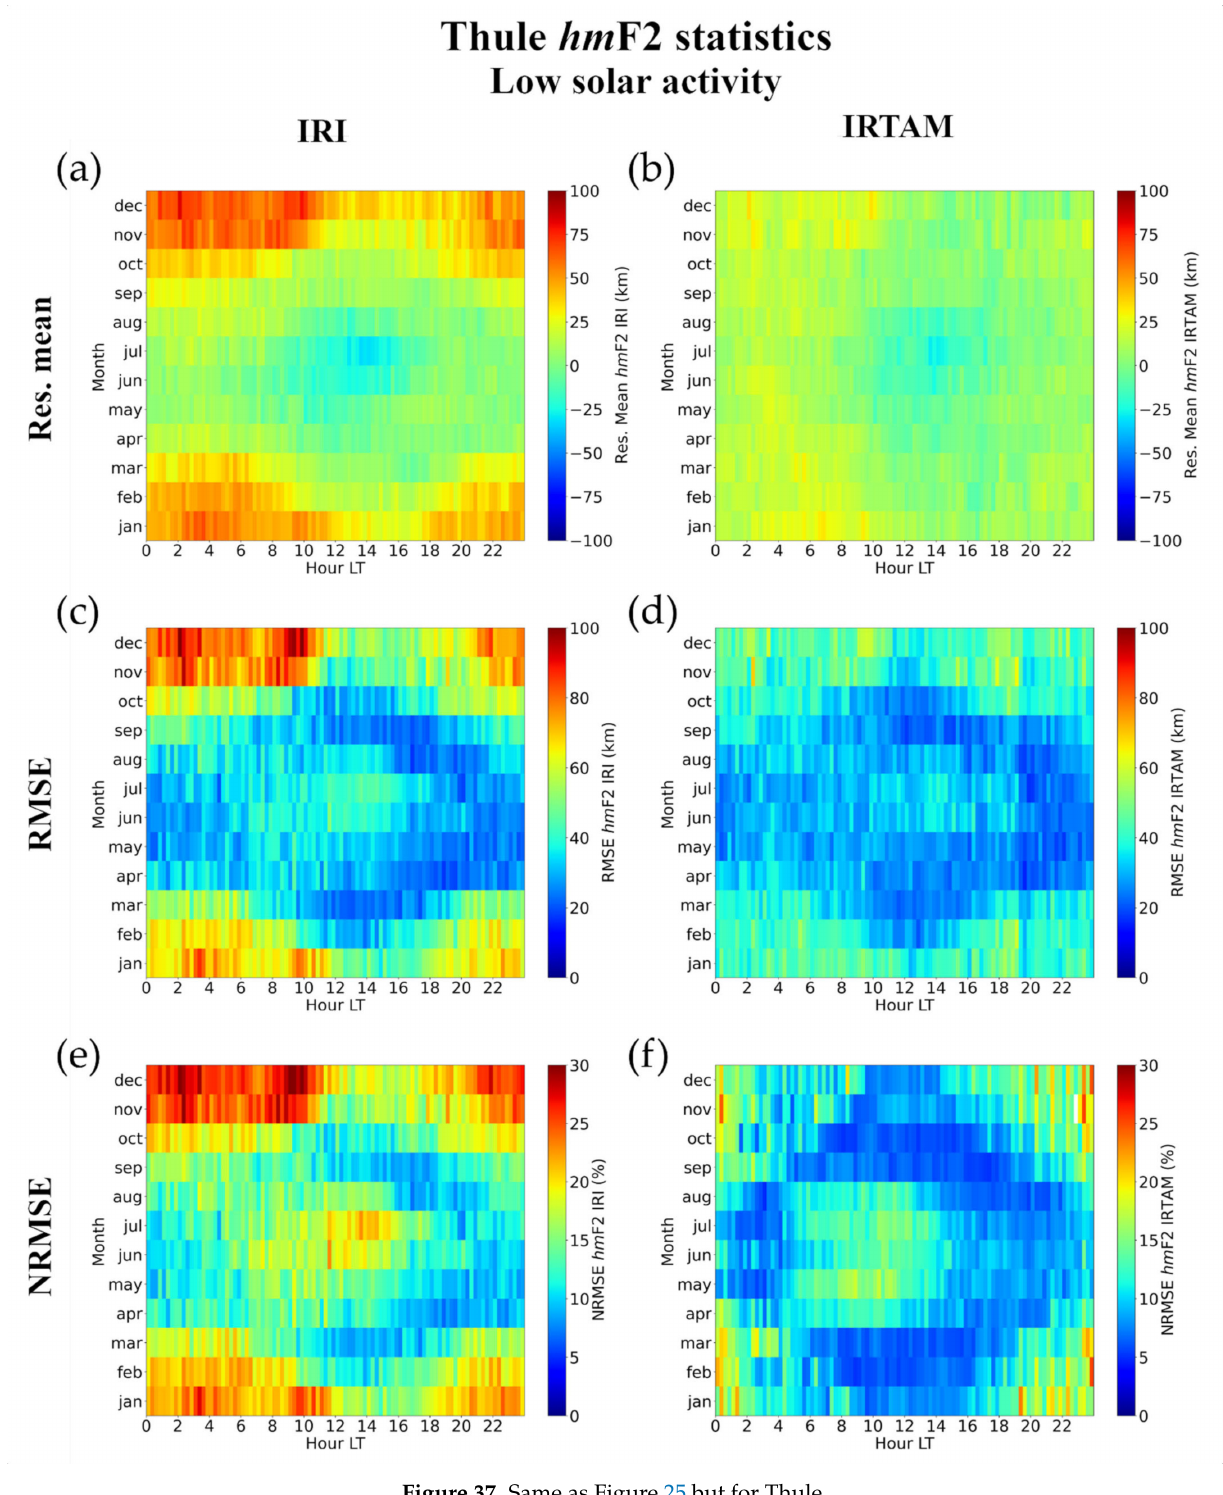
Figure 37. Same as Figure 25 but for